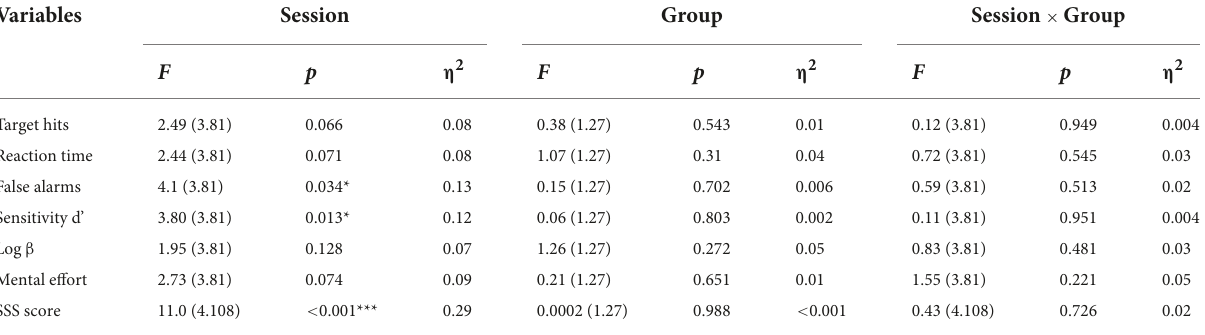
TABLE 2 Behavioral results for vigilance task.